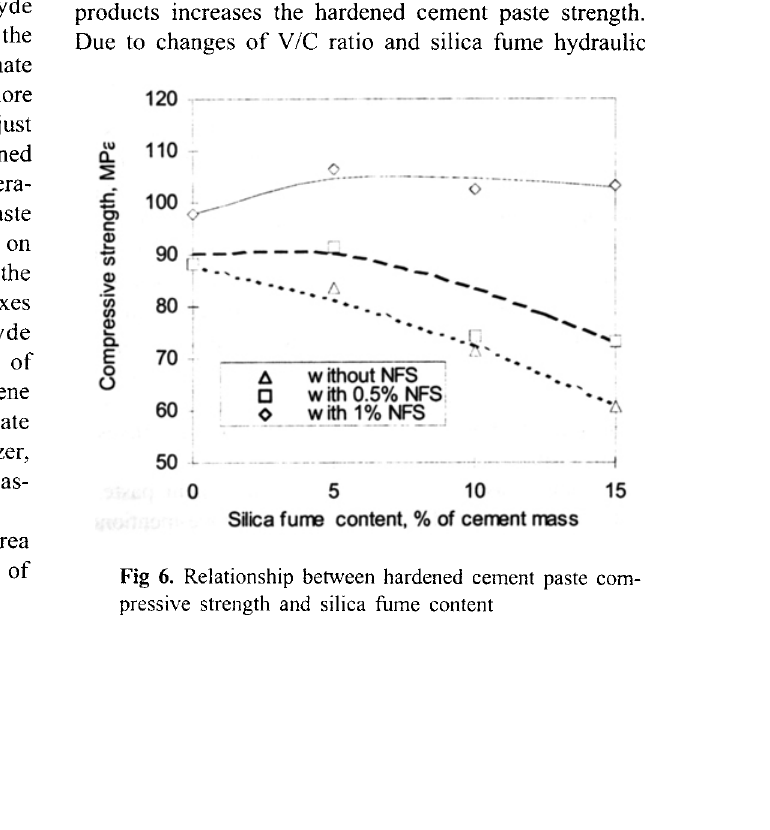
Fig 5. Relationship between water requirement for nor mal consistency cement paste and silica fume content Fig 5 shows that silica fume increases the water re